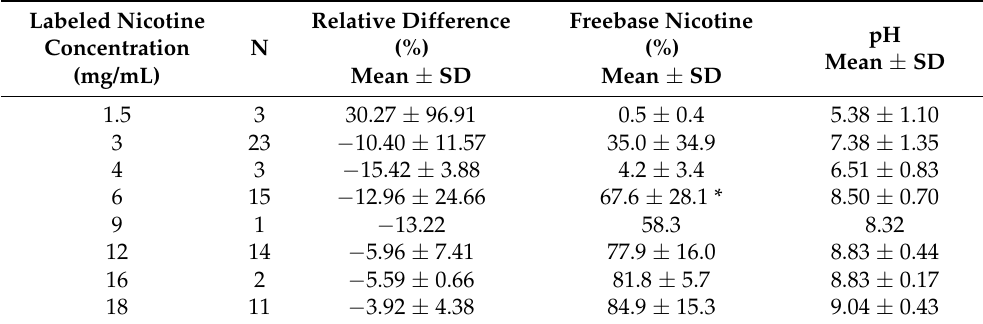
Table 2. Mean difference in nicotine content of different nicotine labeled refill solutions and freebase nicotine content in e-liquids with labeled nicotine level above 0 mg/mL.